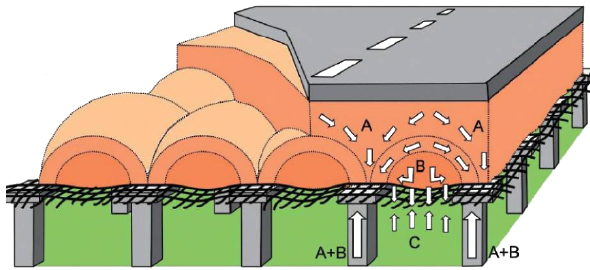
Figure 2. Load distribution in a reinforced piled